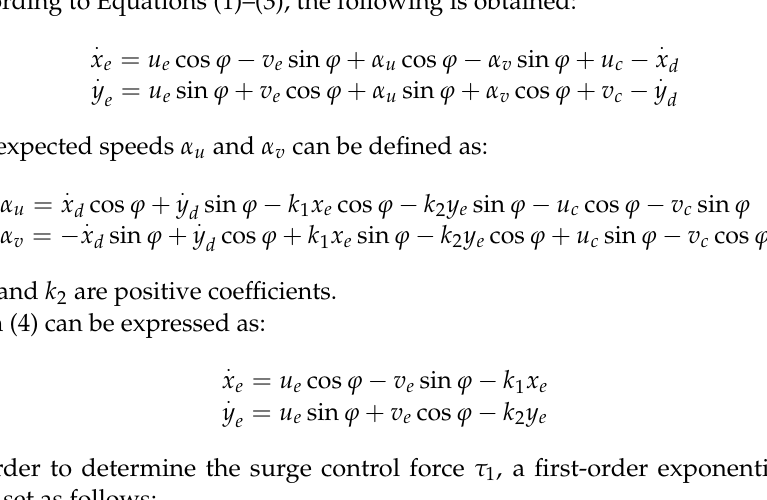
xy z . Figure 1. The earth-fixed and body-fixed coordinate systems, xyz and x b y b z b bb b